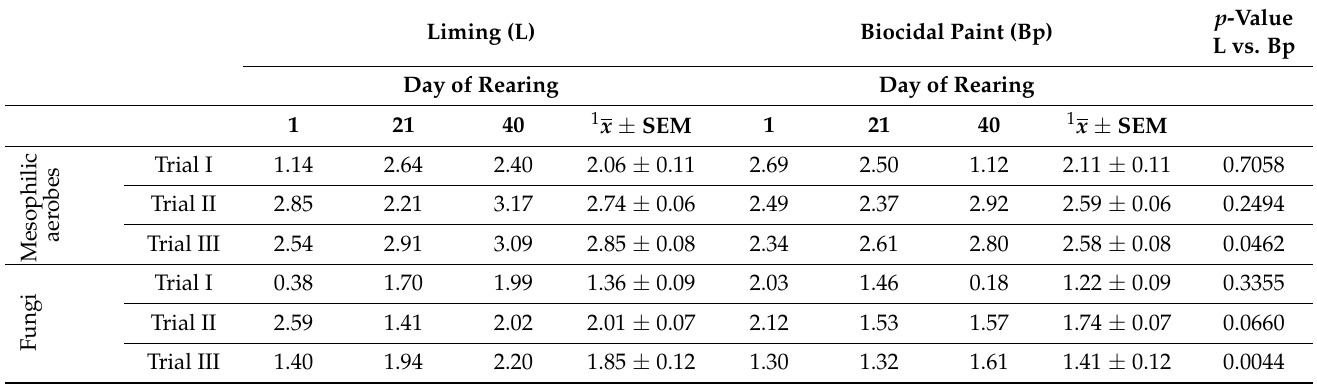
Table 5. Mean values of the total counts of mesophilic aerobes and fungi in the air [log 10 CFU/m 3 ]. Liming (L) Biocidal Paint (Bp)